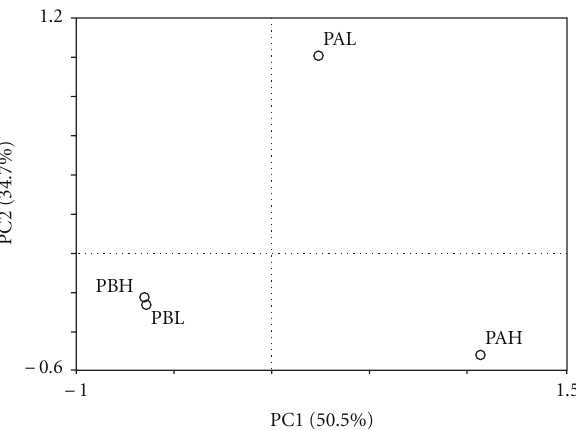
Figure 3: Comparison of bacterial communities in samples PAH, PAL, PBH, and PBL. Principal coordinates plots (PCA) were generated using the presence of each OTU (at a distance level of 3%) found in each clone library. PAL—crude oil from Platform A with low-water content (5%); PAH—crude oil from Platform A with high-water content (60%); PBL—crude oil from Platform B with low-water content (1%); PBH—crude oil from Platform B with high-water content (40%).